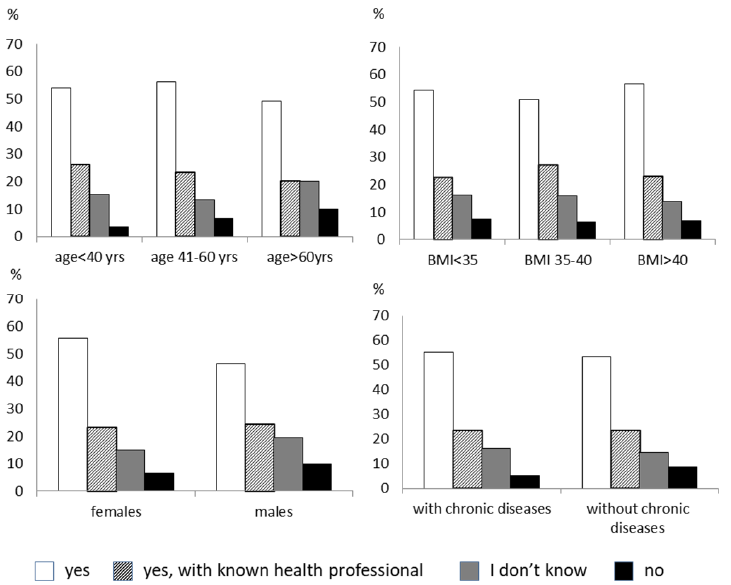
Figure 1. The figure shows the answer to the question: “Would you be like to start an online multidisciplinary intervention for weight management?”. The responders are divided by age, sex, degree of obesity, and the presence of chronic diseases.